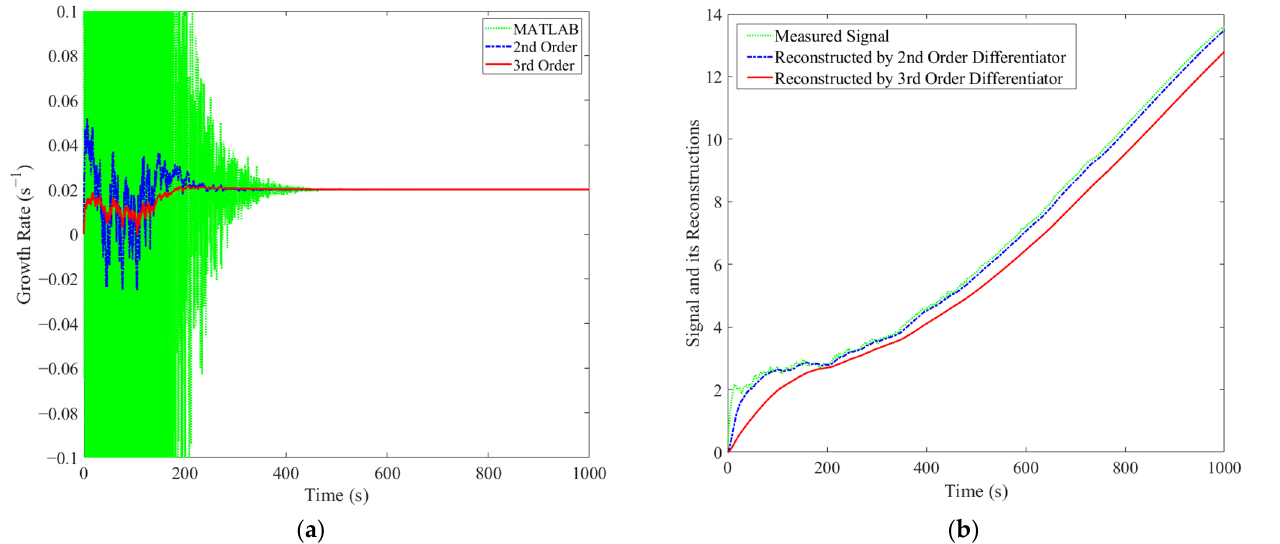
Figure 1. Numerical simulation results for the estimations of the derivative of a given signal provided by different differentiators: ( a ) growth rate, ( b ) measured and reconstructed signals.